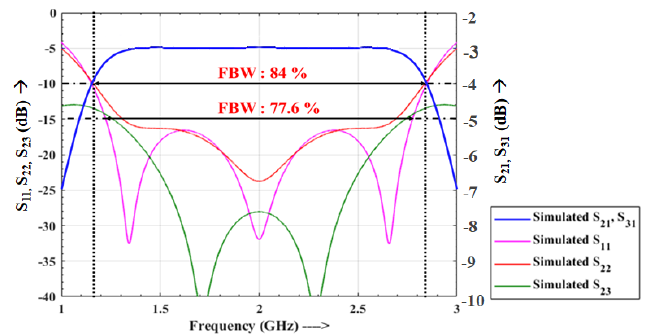
Figure 8. Simulated S-parameters Response for θ c = 55 ◦ .